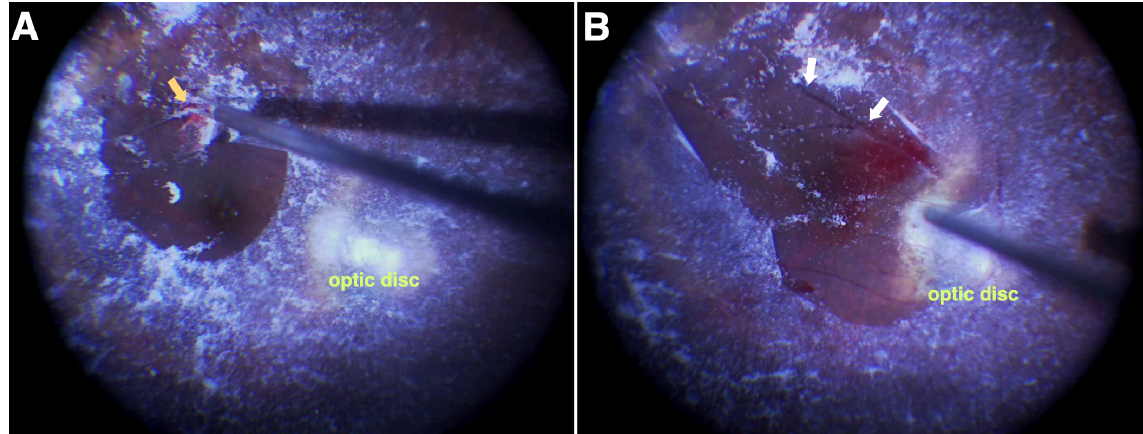
Figure 1: A) When the forceps picked up the epiretinal tissue, the inferior temporal retinal artery was accidentally involved (yellow arrow) and broken off. B) The broken artery (white arrows) was floating and pulsating in the vitreous space. Microscopic bleeding at the broken end and oozing from the retinal cleft that had once enfolded the artery were observed.